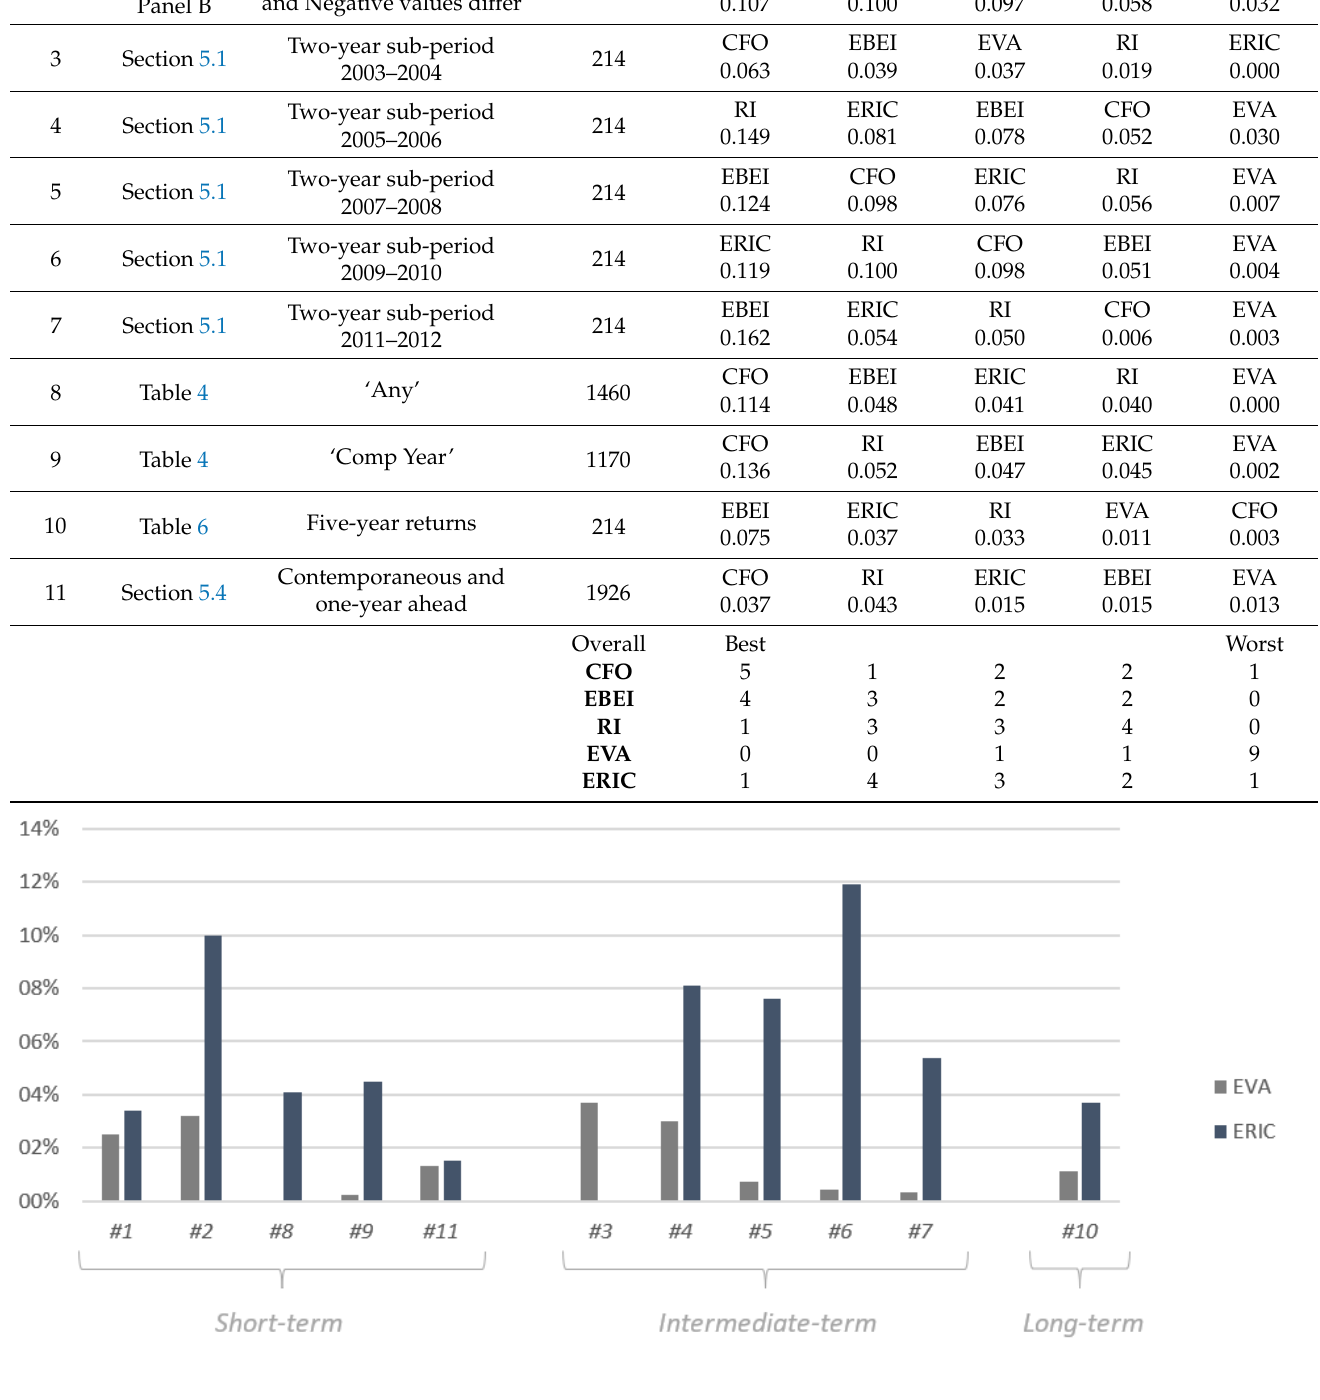
Table 7. Synthesis of the information content of ERIC.